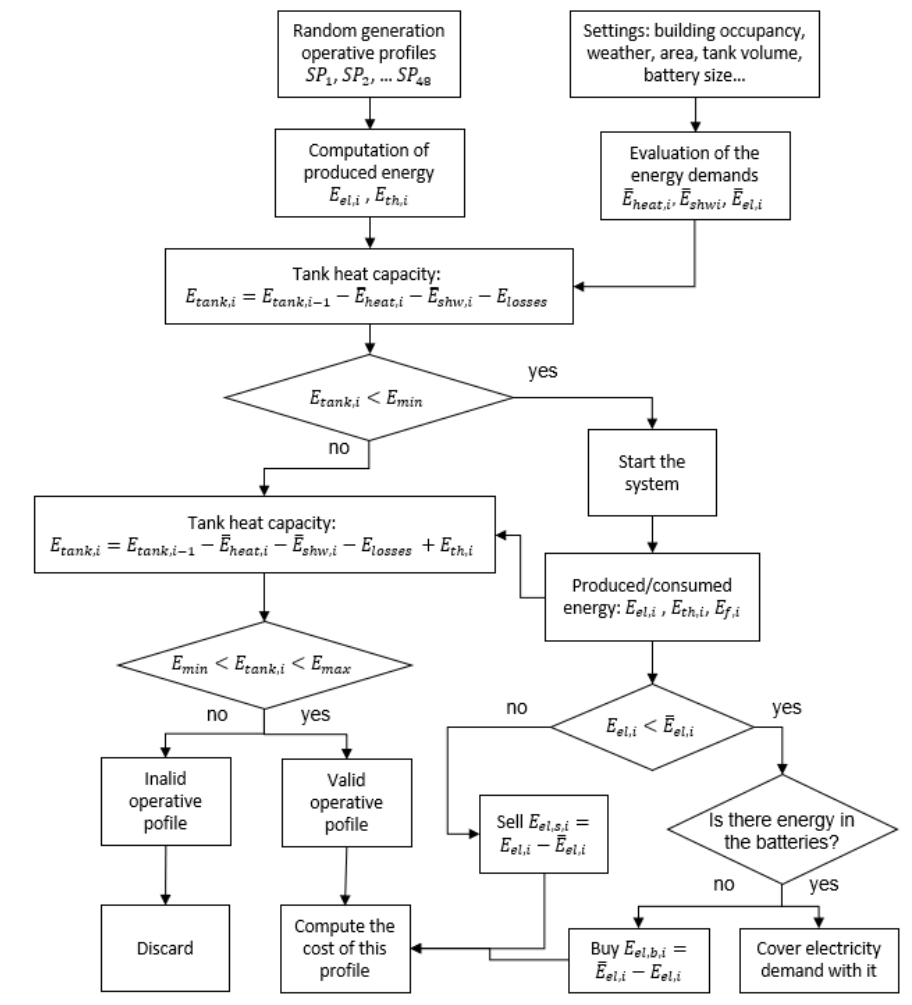
Figure 6. Flowchart of the developed optimization algorithm for the MGT-CHP system. Each randomly generated operative profile is tested. The energy demands are assigned as the input, based on environmental parameters and building occupancy and size. Battery and thermal storage sizes are assigned by the user, and their charge is updated for every time step. If the system fulfills the demand, the operative profile cost is computed; if not, it is discarded and the next one is